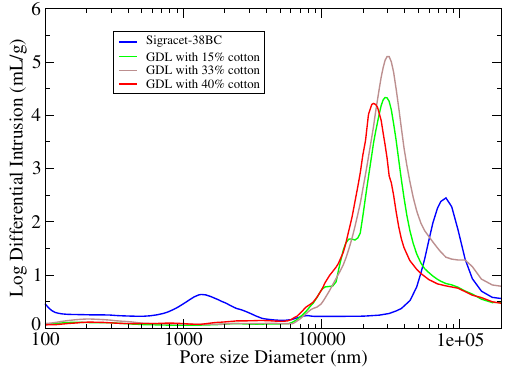
Figure 6. Pore distribution determined by mercury porosimetry technique.